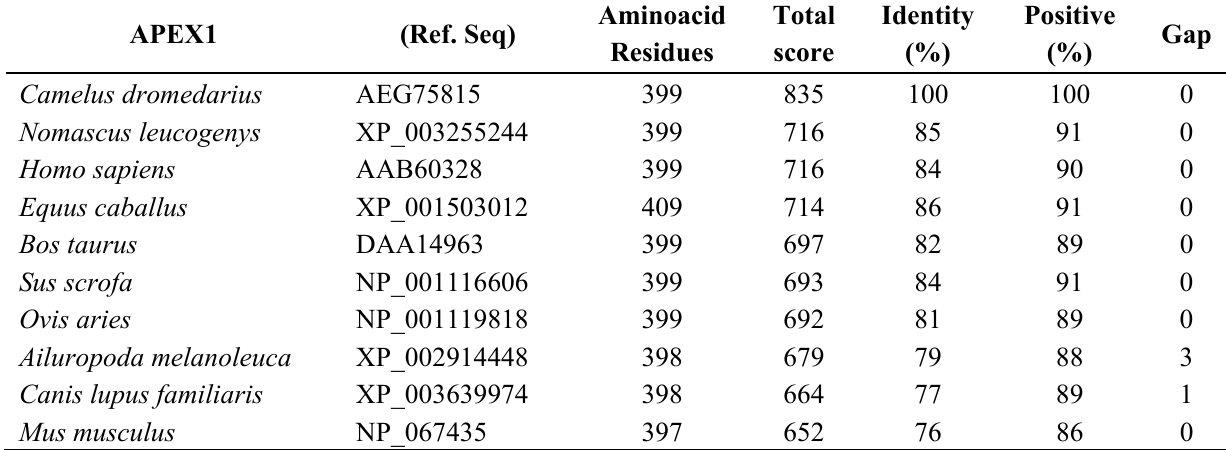
Table 2. Comparison of cLIPA and other LIPA enzymes from different